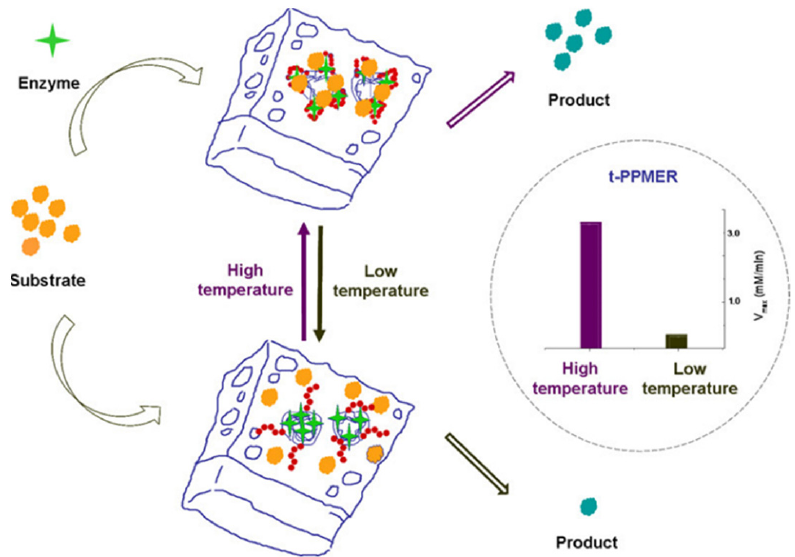
Figure 4. Schematic representation of thermoresponsive behavior of the biocatalyst. T-PPMER stands for thermoresponsive porous polymer membrane enzyme reactor. Reproduced with permission from [52], the American Chemical Society, 2021.